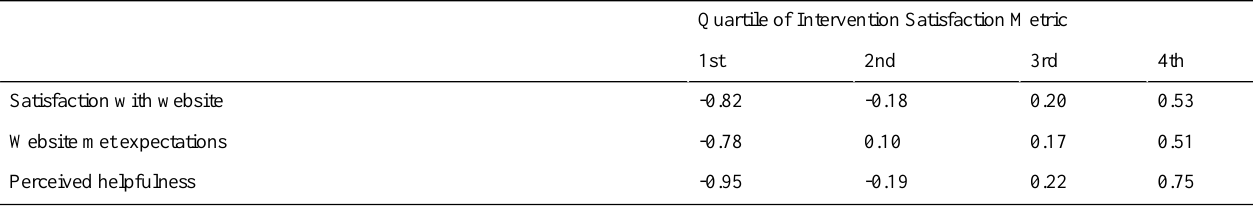
Quartile of Intervention Satisfaction Metric 4th3rd2nd1st